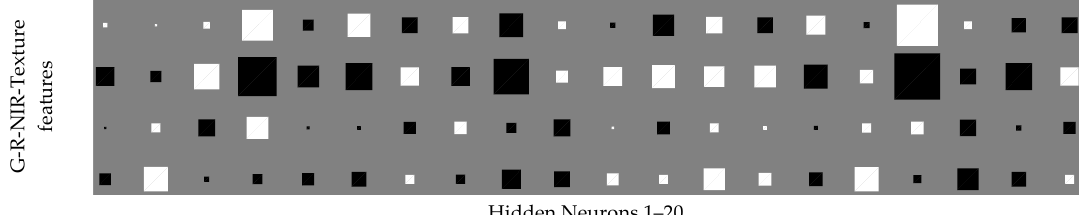
Figure 3. Hinton diagram of the trained MLP-ARD. The vertical axis corresponds to feature while the horizontal shows hidden neurons.